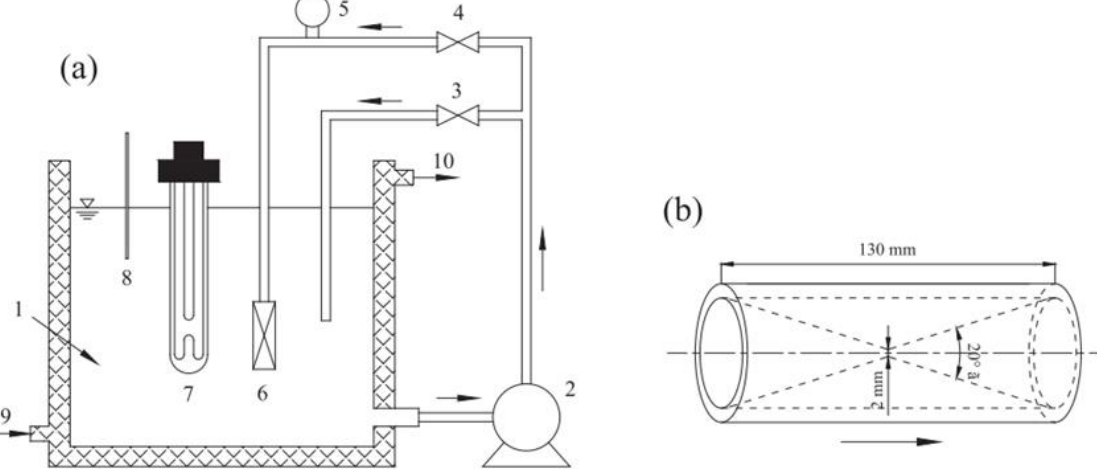
Figure 9. ( a ) Experimental setup for the HC and photocatalytic experiments on TC degradation. The venturi tube and straight pipe with the same length and inlet diameter were alternated, and the UV254 lamp was turned on as needed to conduct the individual or combined processes. (1) Reactor; (2) centrifugal pump; (3 and 4) throttle valves; (5) pressure gauge; (6) venturi tube or straight pipe; (7) UV254 lamp; (8) thermometer; (9) cooling water inlet; (10) cooling water outlet. ( b ) geometry of the venturi tube. Reprinted with permission from [46].